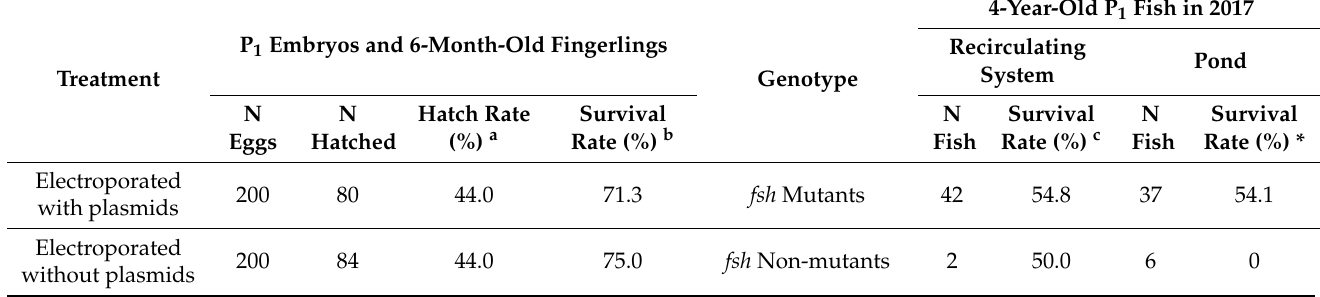
Table 3. Pleiotropic effects of the P 1 embryo, 6-month-old fingerlings and 4-year-old P 1 fish. Survival rate and hatch rate were calculated. Transcription activator-like effector nuclease (TALEN)-plasmid electroporated and no-plasmid electroporated embryos and fingerlings were compared. Mutant and non-mutant channel catfish ( Ictalurus punctatus ) cultured in different environment were